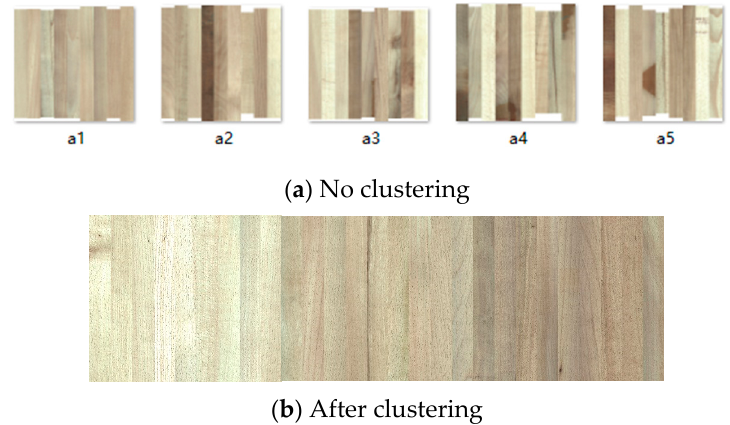
Figure 13. The result images: ( a ) no classification, ( b ) after clustering.